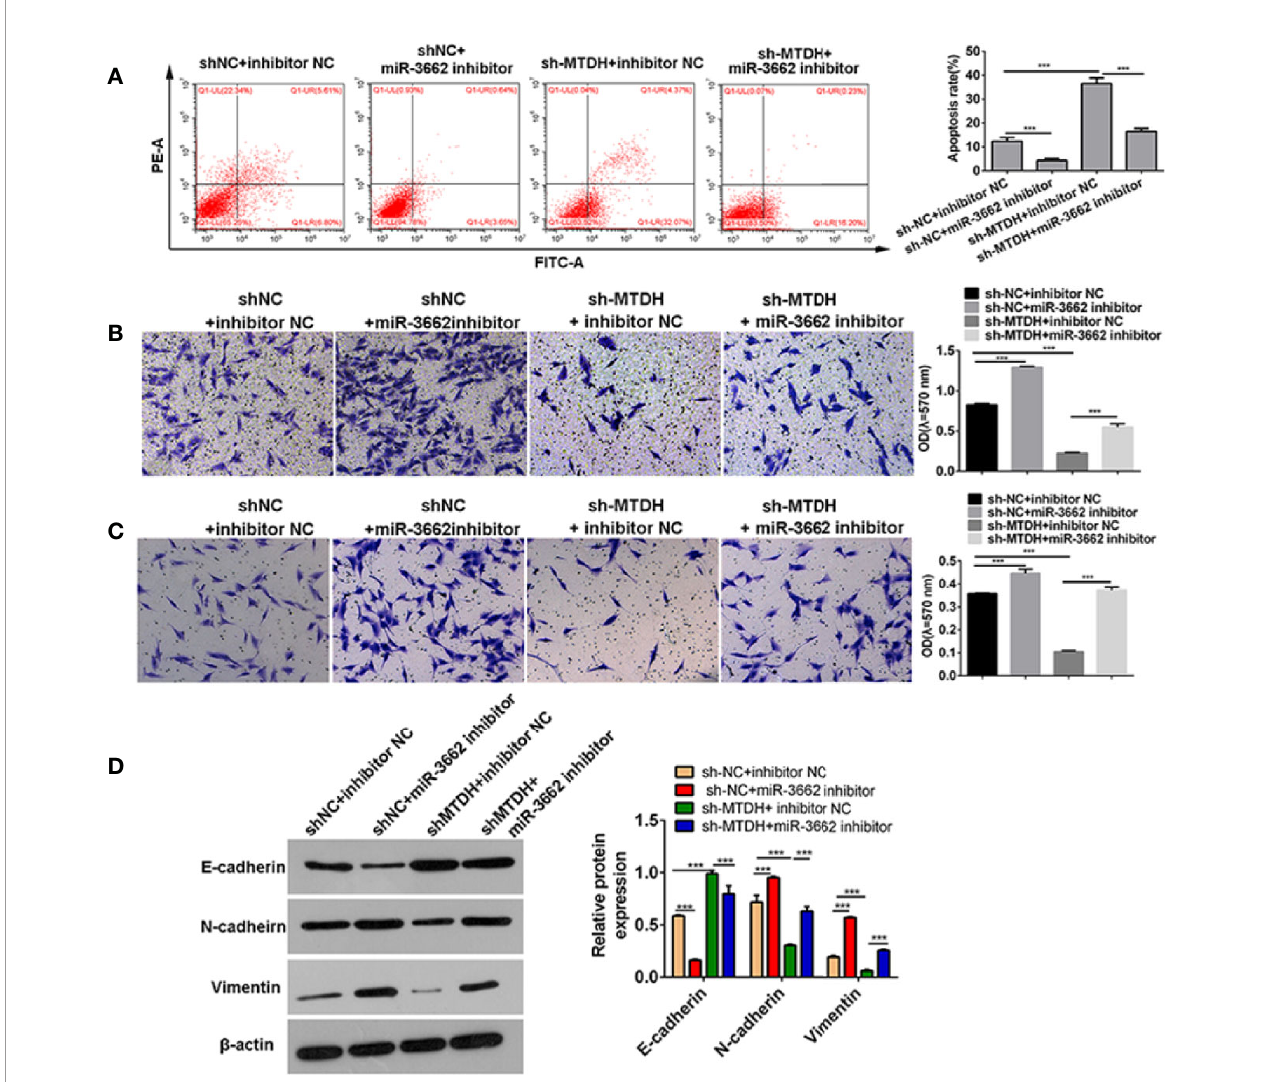
FIGURE 5 | miR-3662 inhibitor rescues the inhibitory effect of shMTDH on osteosarcoma cells. (A) Flow cytometry was used to detect the apoptotic rate of the four groups in the recovery experiment and to verify that miR-3662 could reverse the apoptotic effect of MTDH on osteosarcoma cells. (B) Transwell assays were used to detect the migration of four groups in the recovery experiment and to verify that miR-3662 could reverse the migration effect of MTDH on osteosarcoma cells. (C) Transwell assay was used to detect the invasion of the four groups in the recovery experiment and to verify that miR-3662 could reverse the invasion effect of MTDH on osteosarcoma cells. (D) Western blotting was used to detect the expression of EMT-related proteins (E-cadherin, N-cadherin, and Vimentin) in four groups and to verify that miR-3662 could reverse the effect of MTDH on the EMT of osteosarcoma cells. Data are presented as the mean ± standard deviation of three independent experiments, *** p <